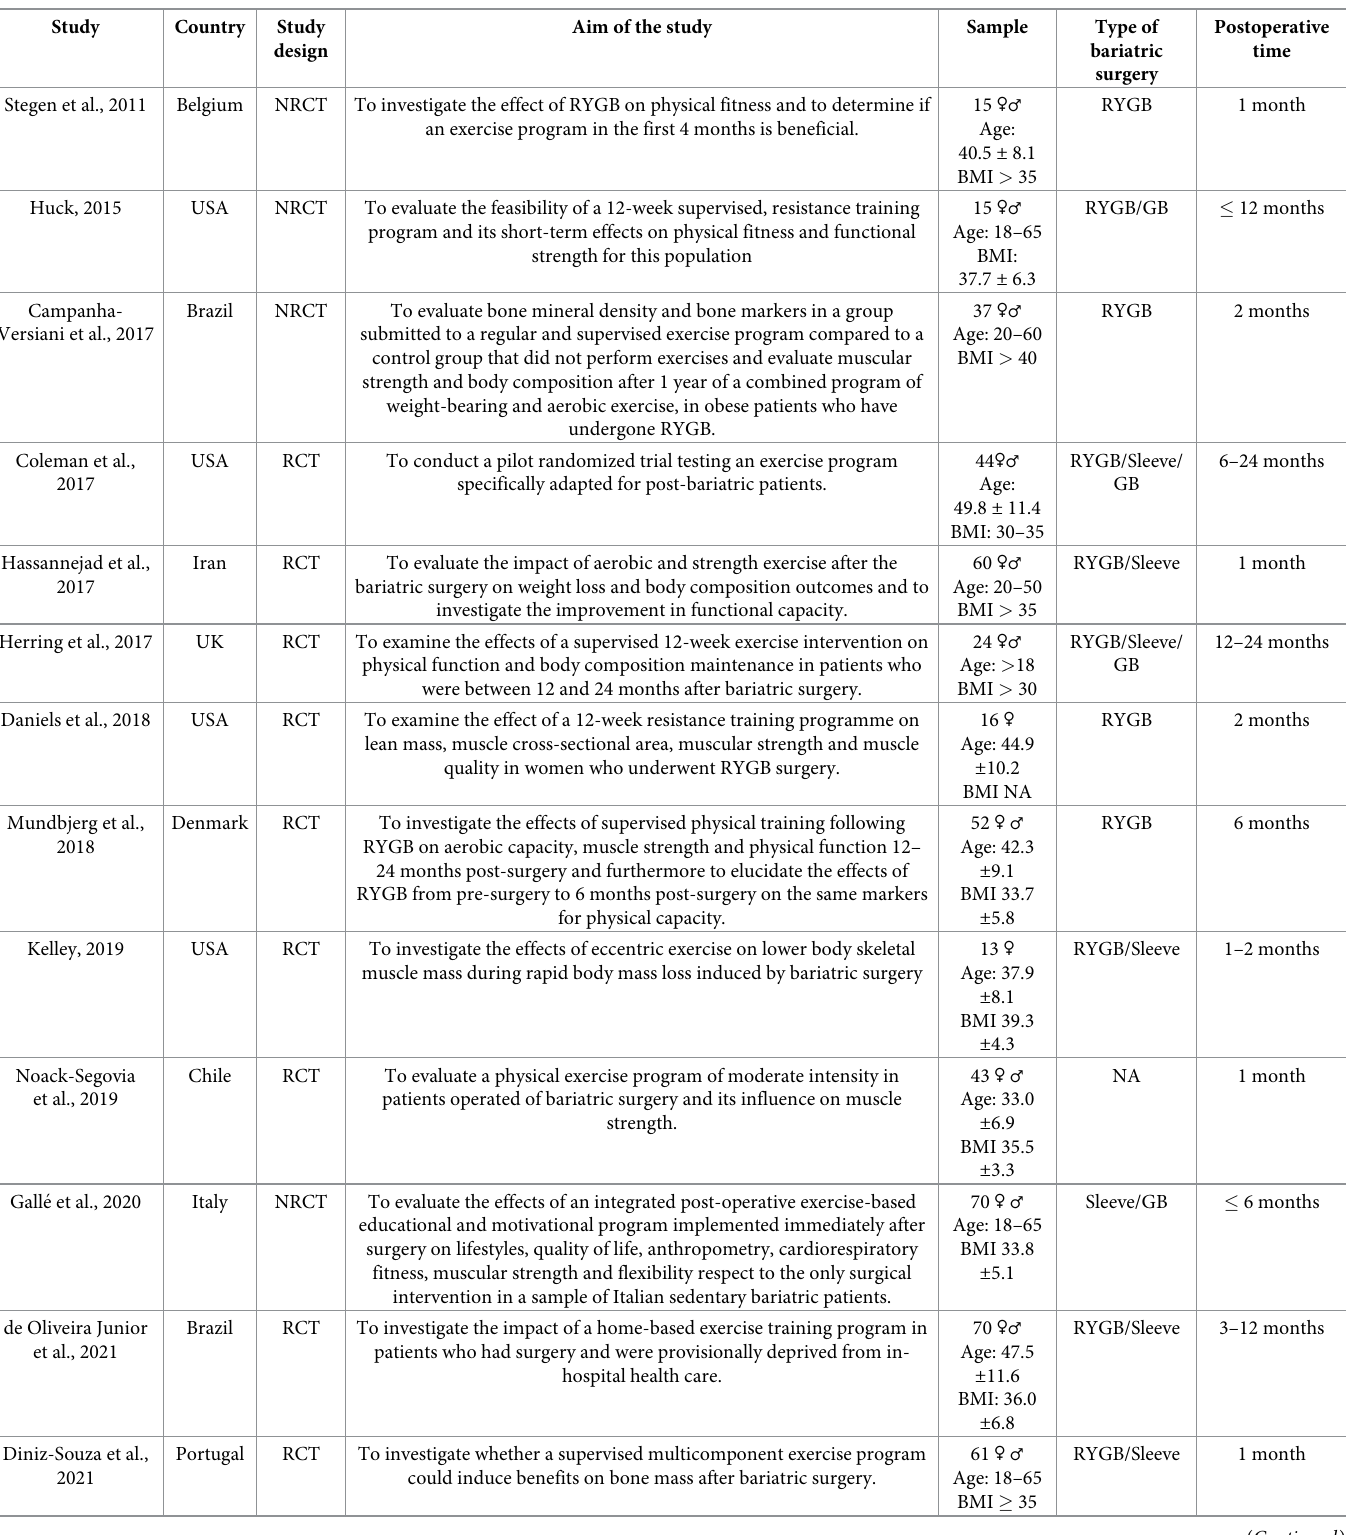
Table 1. Characteristics of included